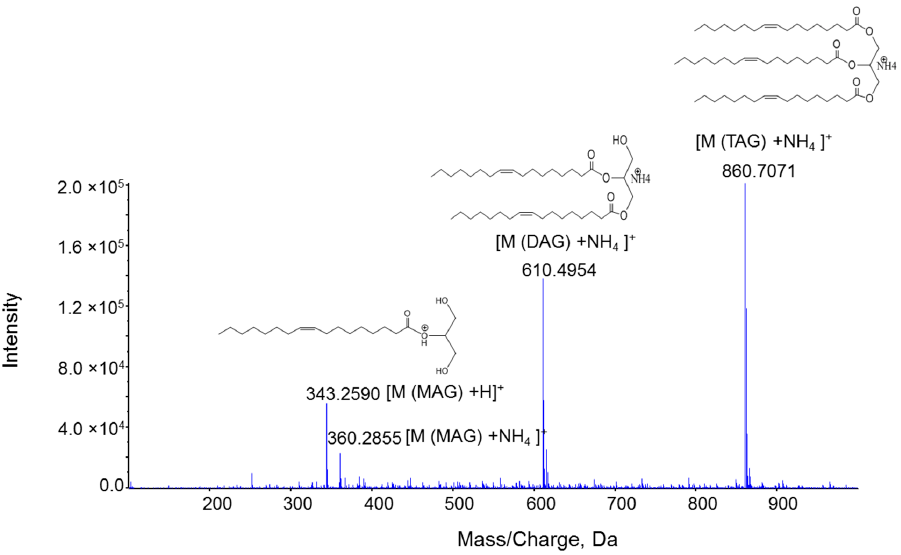
Figure 2. ESI-MS spectra for equal molar concentration (1 µM) of MAG 17:1, DAG d17:1, and TAG t17:1. Spectra were acquired with a TripleTOF 5600+ under the following conditions: GS1 = 10, GS2 = 10, CUR = 15, Temp = 300 °C.